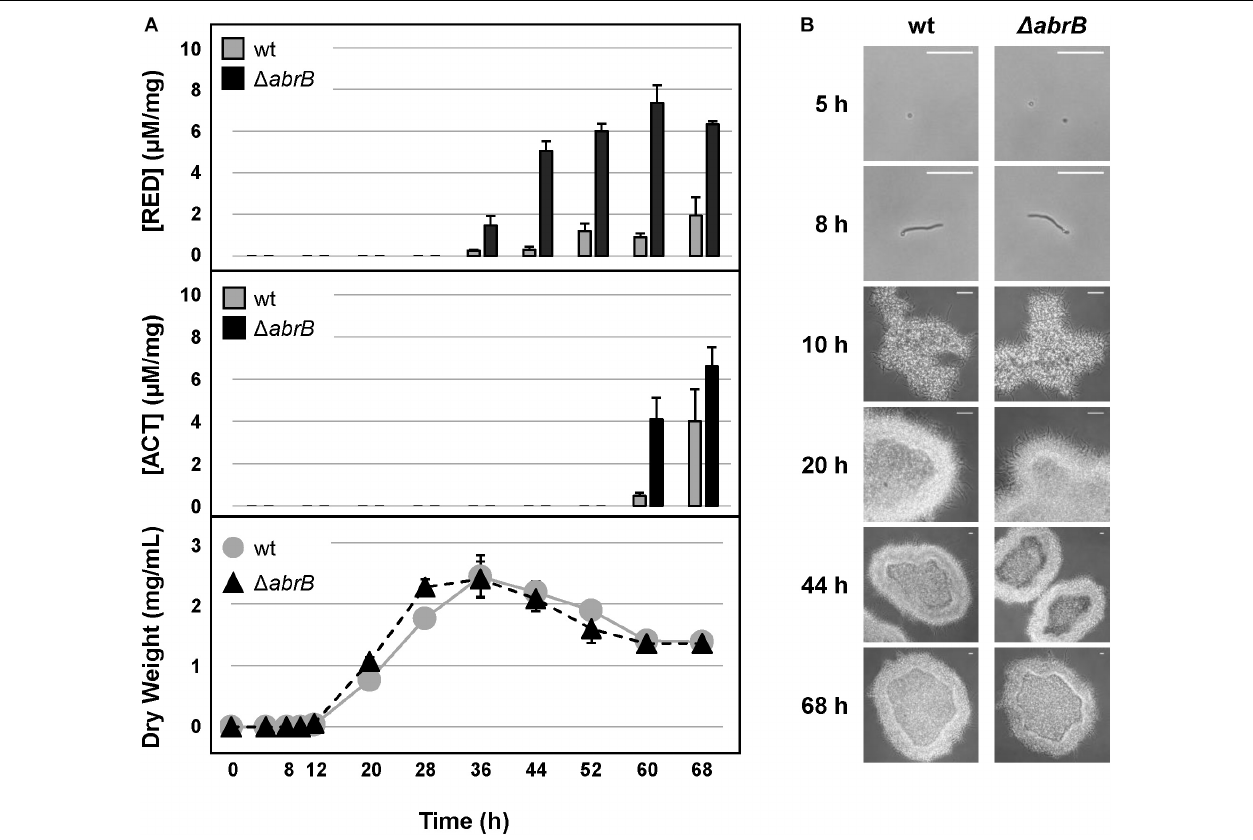
FIGURE 2 | Antibiotic production and growth in liquid medium. (A) RED (top) and ACT (middle) production ( µ M/mg mycelium) along the growth curves of S. coelicolor M145 wild-type strain (wt, gray circles) and the mutant (cid:49) abrB (black triangles) in NMMP liquid medium (bottom). Error bars show the standard deviation of the quadruplicate assays. (B) Germination and growth progression of the wt and (cid:49) abrB strains (photomicrographs). White-bar (up-right): 50 µ